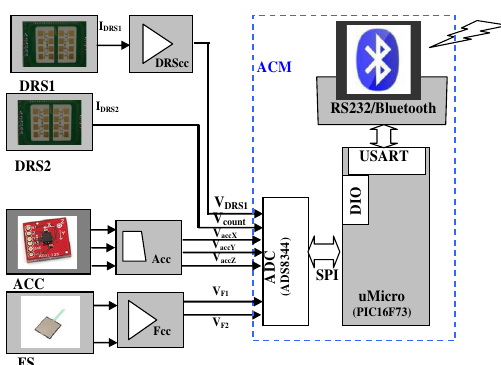
Figure 6. Sensing, acquisition and communication block diagram (DRS1, DRS2 = Doppler radar sensors; FS = piezo- resistive force sensors; DRScc = Doppler radar sensor condi- tioning circuit; Fcc = force conditioning circuit; ACC = accelerometer ADXL335; ACM = acquisition and data commu- nication module.